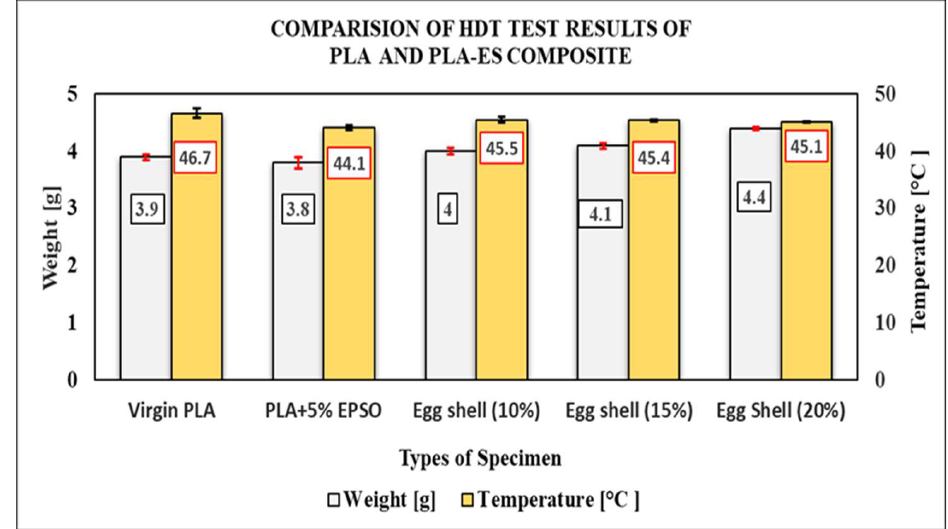
Figure 12. Comparison of HDT test results of PLA and PLA–ES composite.